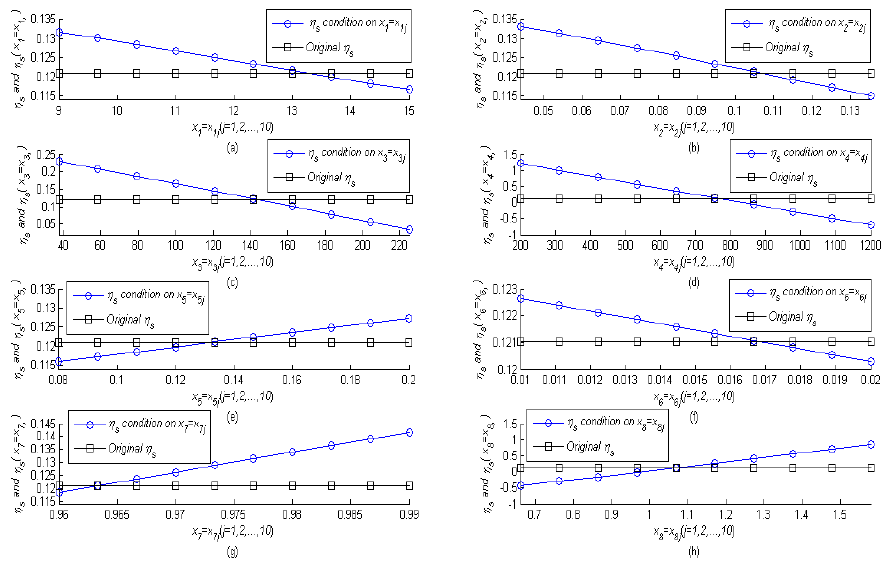
( j = 1,2, . . . ,10 ) , in which x i = x ij